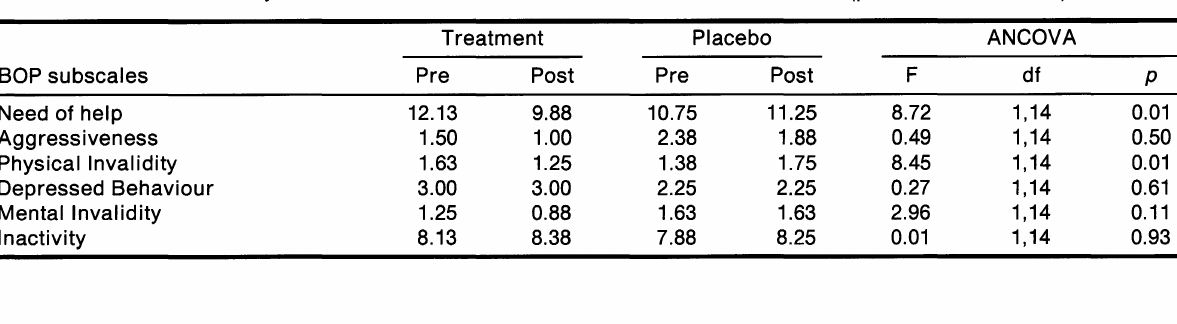
TABLE IV. Means and analyses of covariance of the BOP Geriatric Observation Scale (pre-test as covariate) BOP